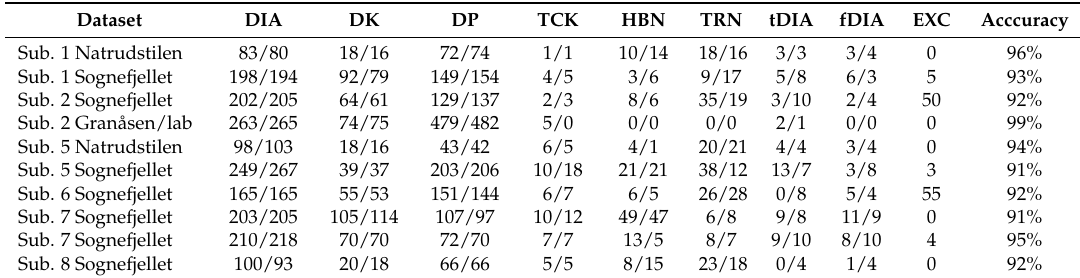
Table 2. Table summarizing the classification results of the 10 test sets from 6 subjects. Each row represents one test dataset while the columns indicate the sub-techniques. The numbers above the slash is the number of cycles classified as the class indicated in the column header, while the numbers below the slash is the number of cycles labeled as the class indicated in the column header.